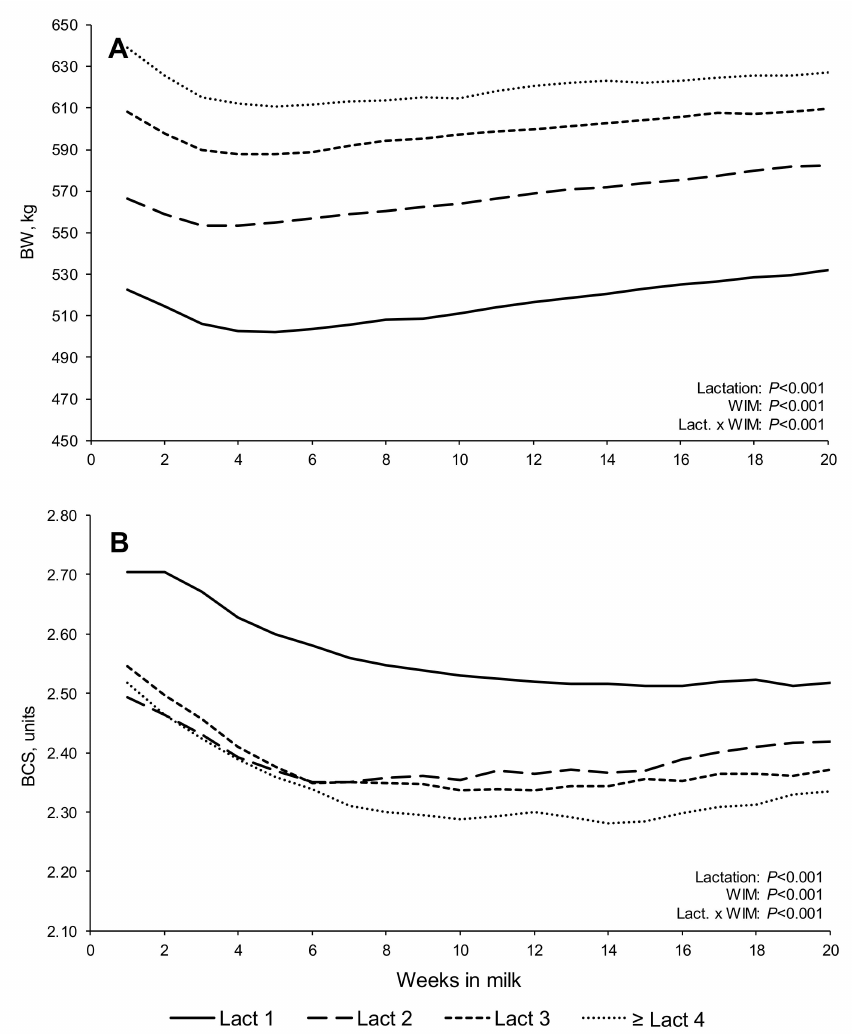
Figure 3. Least squares means, adjusted by the random crossed effects of study and cow, for body tissues reserves variables—body weight (BW; ( A )); and body condition score (BCS; ( B ))—in early lactation dairy cows (1–20